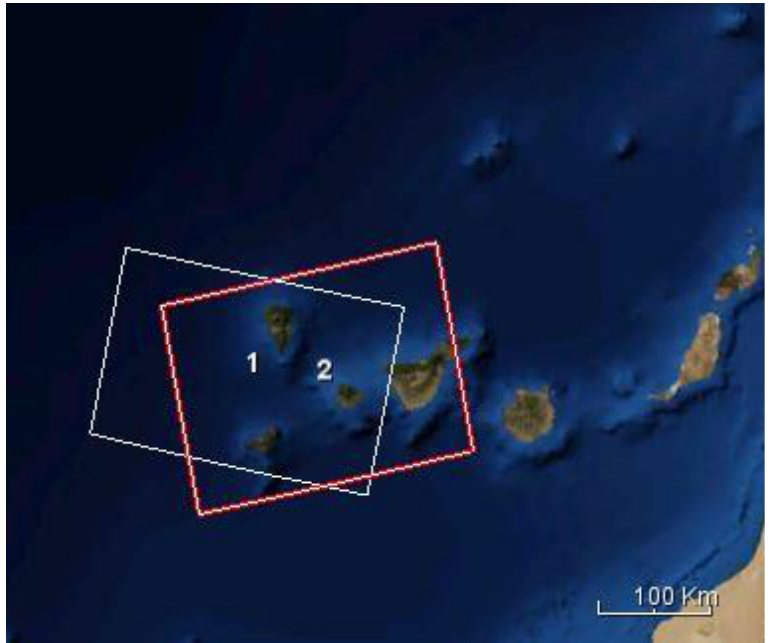
Figure 2. Sentinel-1 data frames. The red square corresponds to the Sentinel-1 data obtained during the ascending pass, while the white square represents the data frame for Sentinel-1 data collected during the descending pass. Table 1. Sentinel-1 data.